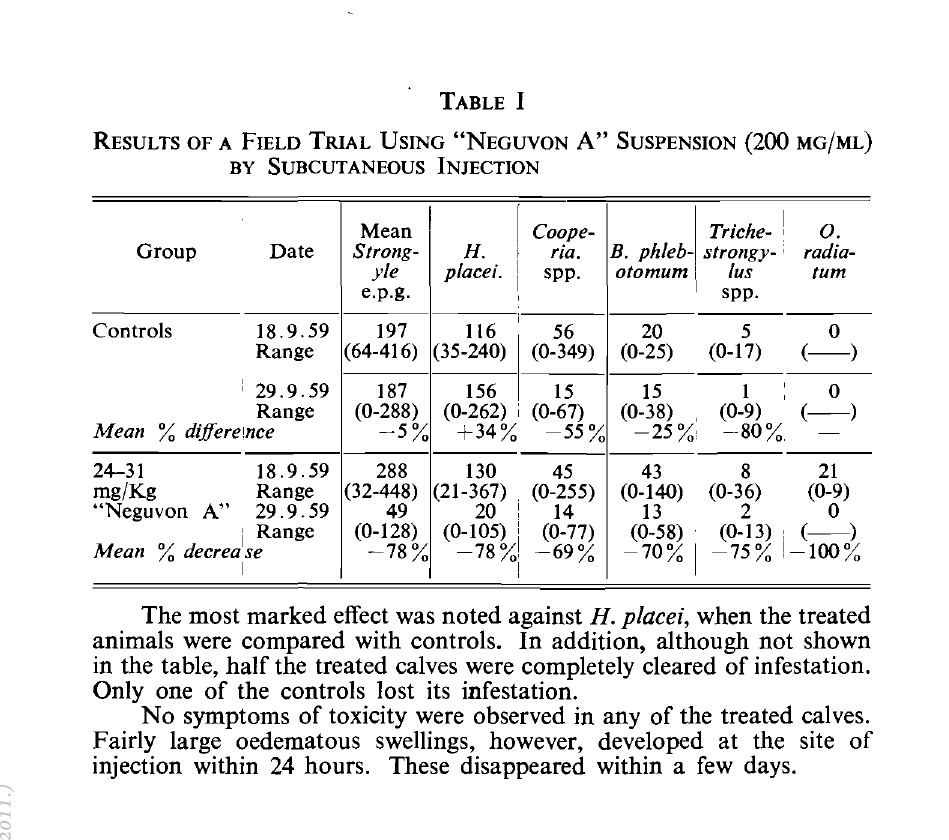
RESULTS OF A FIELD TRIAL USING "NEGUVON A" SUSPENSION (200 MG/ML) BY SUBCUTANEOUS INJECTION I o. I Coope- Mean I Triche- ! Group